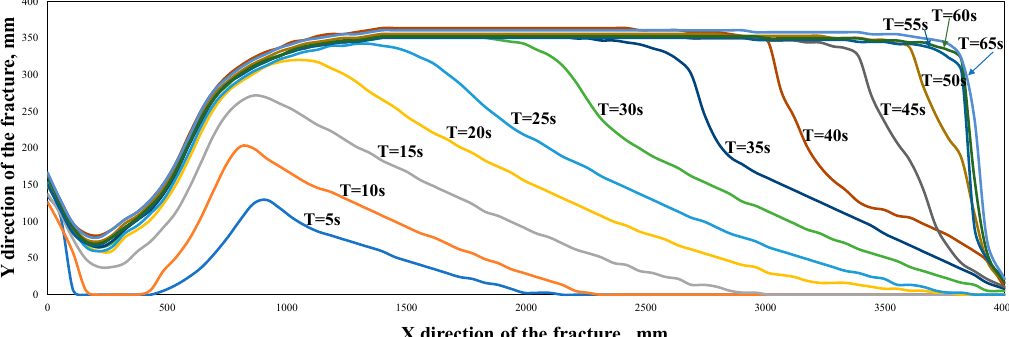
Figure 8. Proppant dune growth trajectory from for the simulation of the control sample.